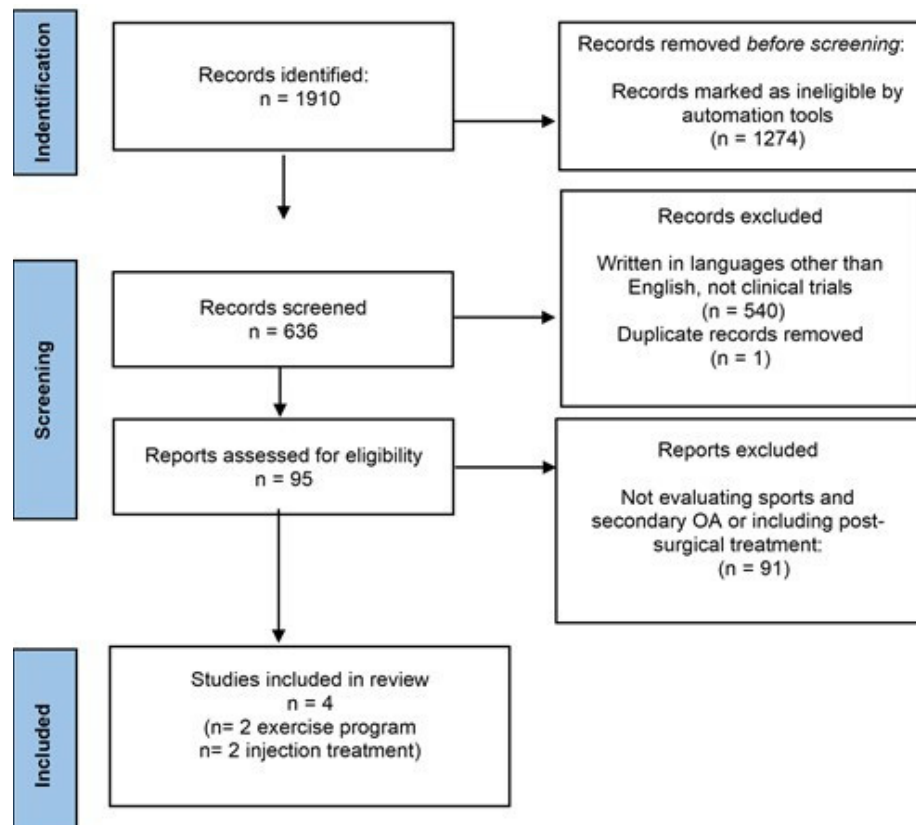
Figure 1. PRISMA Statement flow-chart describing the studies selection strategy.